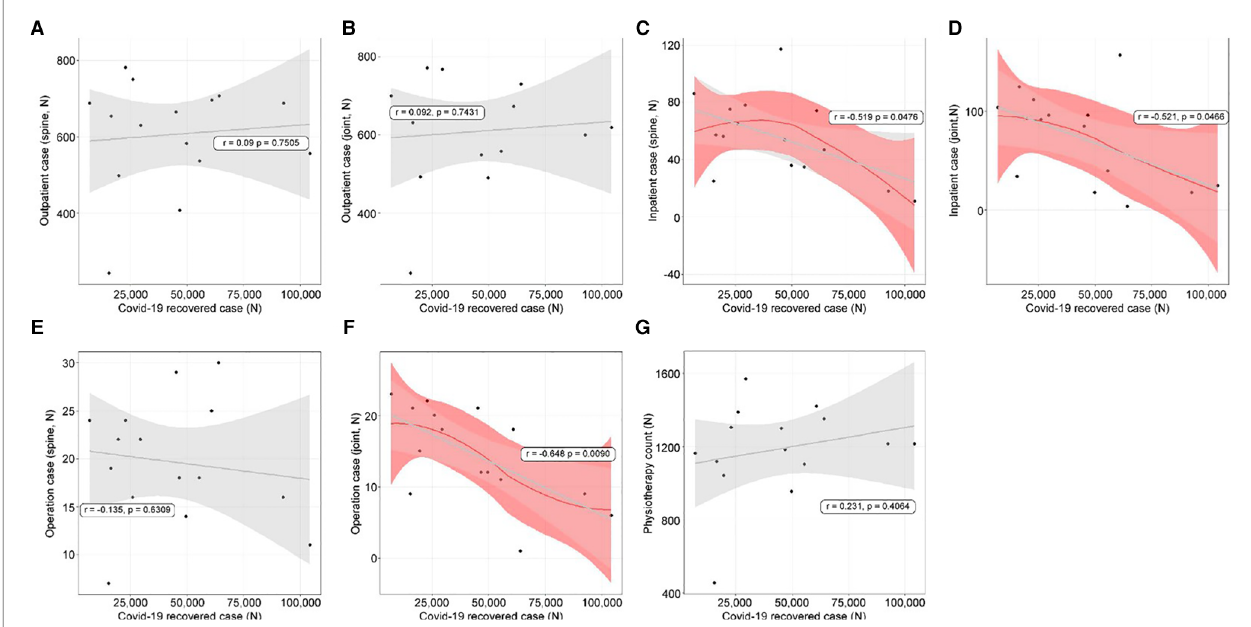
FIGURE 4 | The linear relationships between cases that recovered from coronavirus disease 2019 (COVID-19) and orthopedic hospital visiting patterns. ( A ) Spine outpatient count; ( B ) Joint outpatient count; ( C ) Spine inpatient count; ( D ) Joint inpatient count; ( E ) Spine operation patient count; ( F ) Joint operation patient count; ( G ) Physiotherapy patient count.